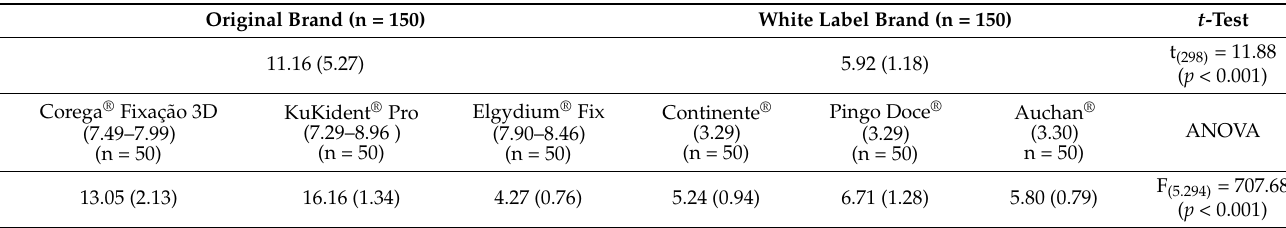
Table 2. Adhesive retention compared by type of brand and brand.